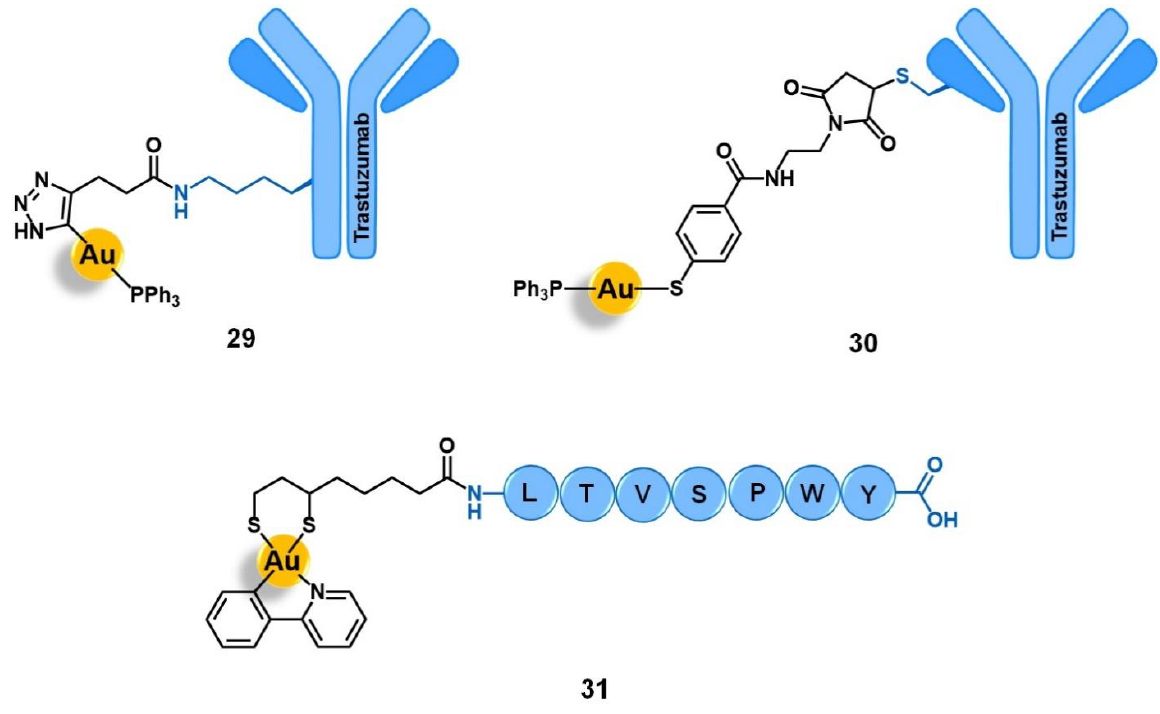
Figure 10. Conjugates of Au(I) with the monoclonal antibody Trastuzumab ( 29 and 30 ) or Au(III) with the peptide LTVSPWY ( 31 ) for targeting the human epidermal growth factor receptor 2 (HER2).